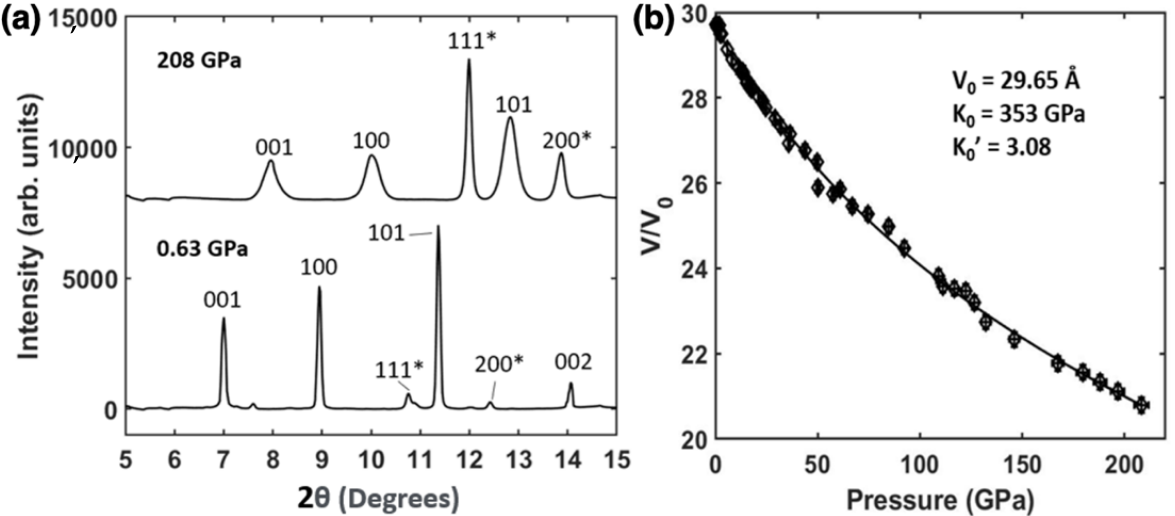
Figure 2. ( a ) Axial X-ray diffraction patterns of HfB2 and Pt (*) powder at 0.63 GPa and 208 GPa. ( b ) Pressure volume curve of HfB 2 to 208 GPa with the fitted 3rd Order Birch–Murnaghan equation of state. The fitted parameters are shown in the inset.